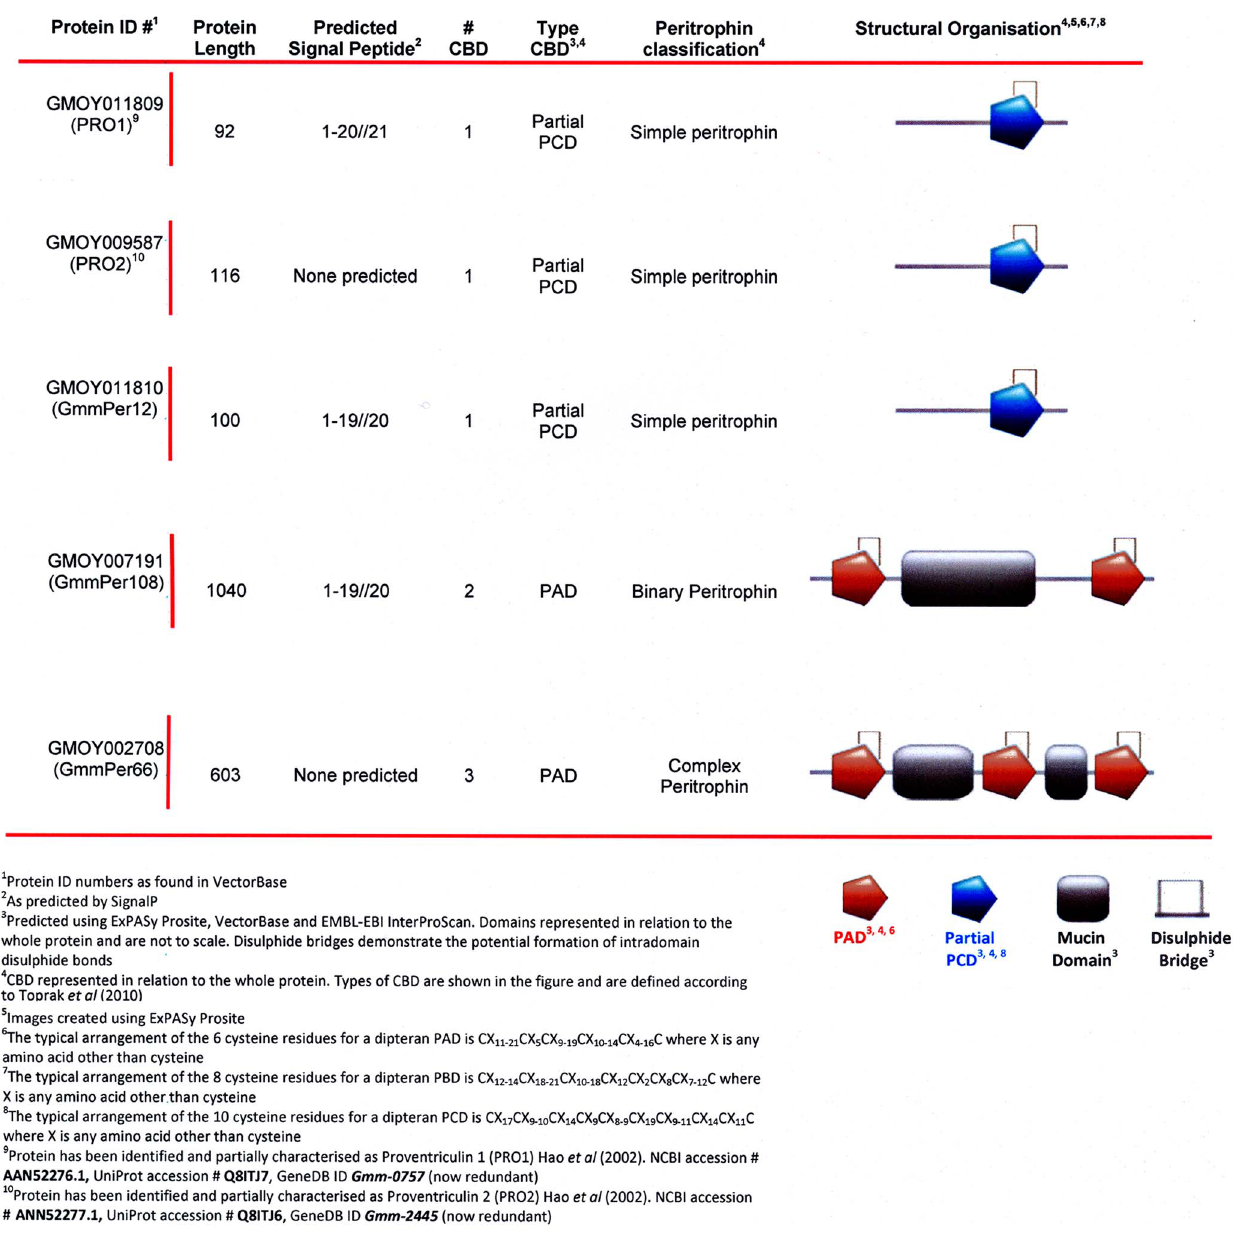
Figure 4. Classification and partial characterization of G.m.morsitans peritrophic matrix (PM) peritrophin and peritrophin-like proteins, containing 1 or more chitin binding domains (CBD), as identified by